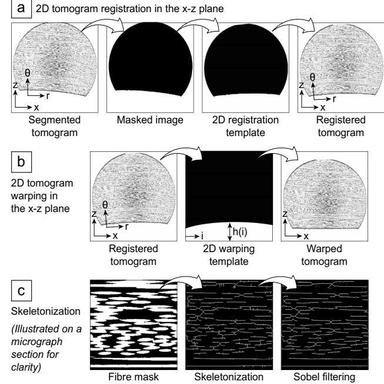
Treatment of X-μCT tomograms in the x-z plane: (a) registration; (b) warping; (c) skeletonization (illustrated on a micrograph section for clarity).